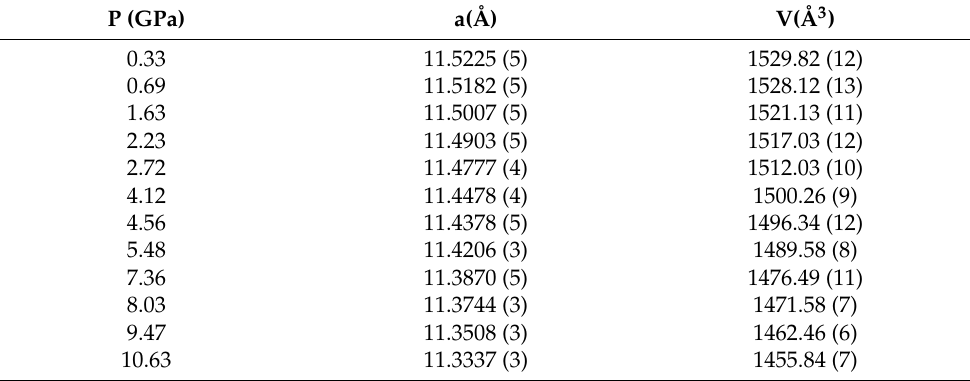
Table 1. Unit cell parameters for garnet obtained from indexing SXD data in CrysAlis [39]. Pressure was measured using ruby fluorescence. Uncertainty on pressure is <2.5% [51]. Unit cell parameters and volumes are obtained from SXD. Uncertainties on these are in